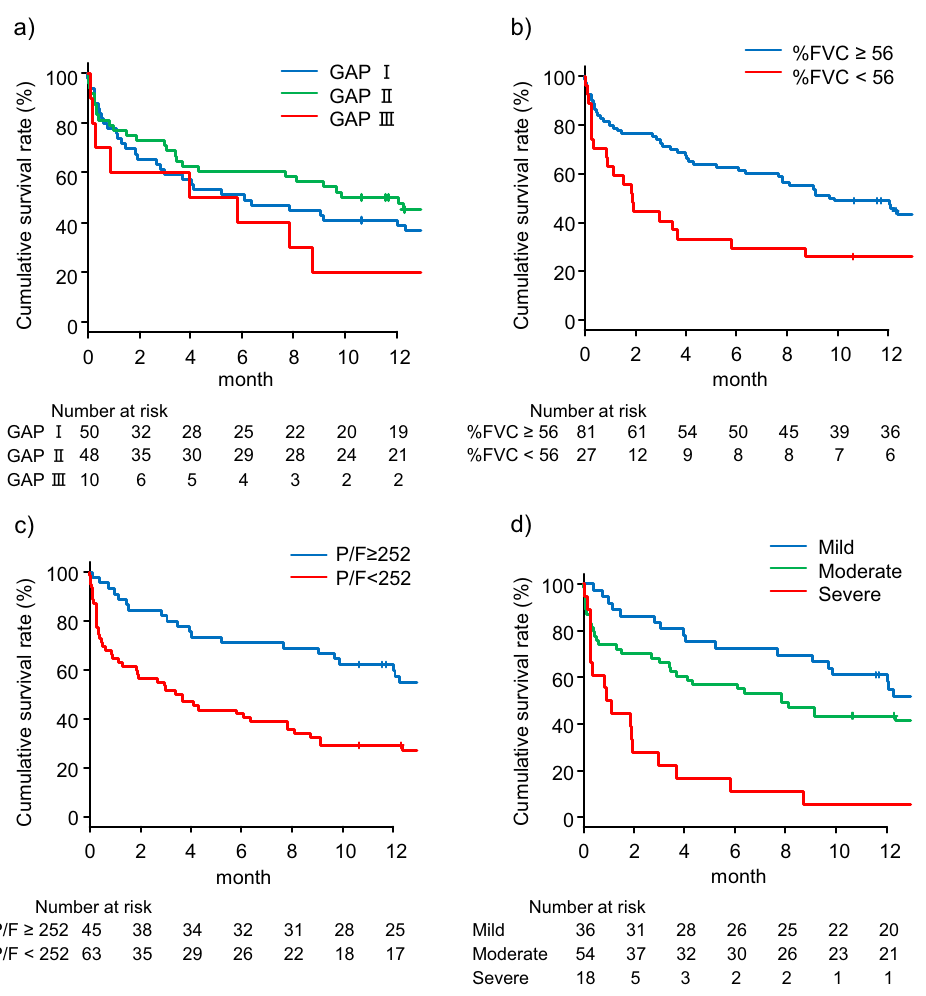
Figure 3. Post-AE cumulative survival rates by the GAP model and prognostic classification model 1. ( a ) The post-AE 90-day cumulative survival rates of the patients by GAP stage: GAP stage I, 59.3% (95% CI 44.3–71.5); GAP stage II, 68.8% (95% CI 53.6–79.8); and GAP stage III, 60% (95% CI 25.3–82.7), with GAP stage I compared with GAP stage II (adjusted p = 0.45 by Wilcoxon test) and GAP stage II compared with GAP stage III (adjusted p = 0.26, by Wilcoxon test). The discrimination performance (C-index) of this model for post-AE 90-day survival was 0.526 (95% CI 0.417–0.634). ( b ) The post-AE 90-day cumulative survival rates of the patients with AE-IPF who had %FVCs ≥ 56% and those with %FVCs < 56% were 72.6% (95% CI 61.4–81.0) and 40.7% (95% CI 22.5–58.2), respectively ( p < 0.01 by Wilcoxon test). ( c ) The post-AE 90-day cumulative survival rates of the patients with AE-IPF who had P/F ratios ≥ 252 Torr and those with P/F ratios < 252 Torr were 82.2% (95% CI 67.6–90.7) and 50.8% (95% CI 38.7–63.3), respectively ( p < 0.01 by Wilcoxon test). ( d ) The post-AE 90-day cumulative survival rates of the patients by total risk scores of 0 (mild), 1 (moderate), and 2 (severe) were 83.3% (95% CI 66.7–92.1), 66.2% (95% CI 51.9–77.2), and 22.2% (95% CI 6.9–42.9), with the mild group compared with the moderate group (adjusted p = 0.04 by Wilcoxon test) and the moderate group compared with the severe group (adjusted p < 0.01 by Wilcoxon test). The discrimination performance (C-index) of this model for post-AE 90-day survival was 0.702 (95% CI 0.61–0.80). AE acute exacerbation, FVC forced Vital Capacity, GAP Gender-Age-Physiology, IPF idiopathic pulmonary fibrosis, P/F PaO 2 -to-FiO 2